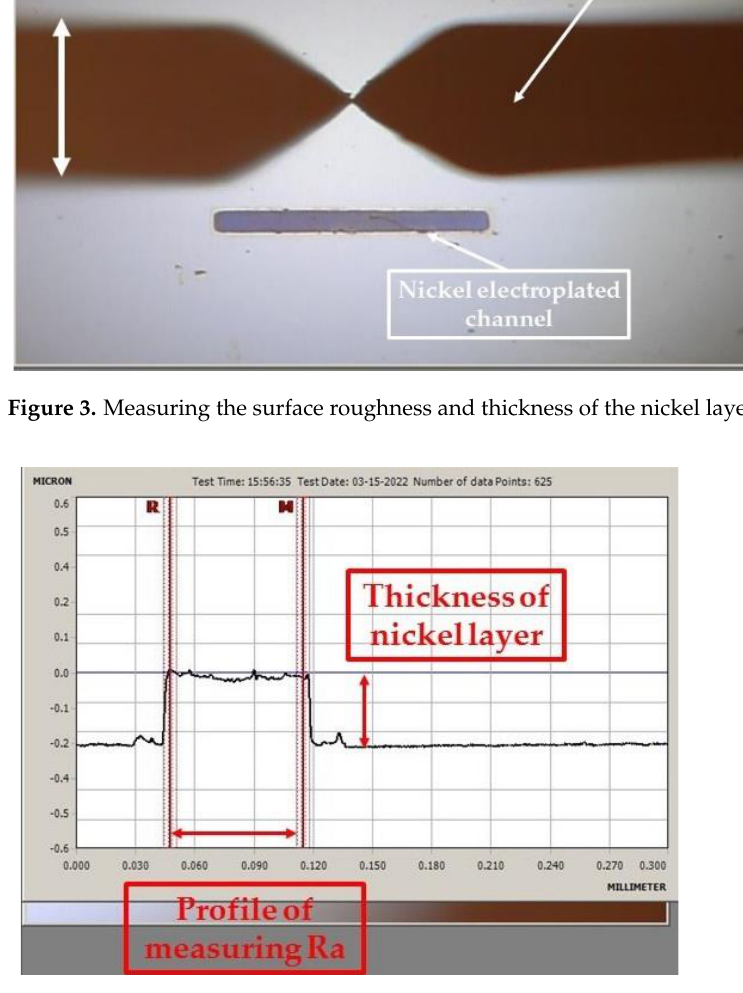
Figure 4. A sample of evaluating nickel surface roughness and thickness using the profilometer.